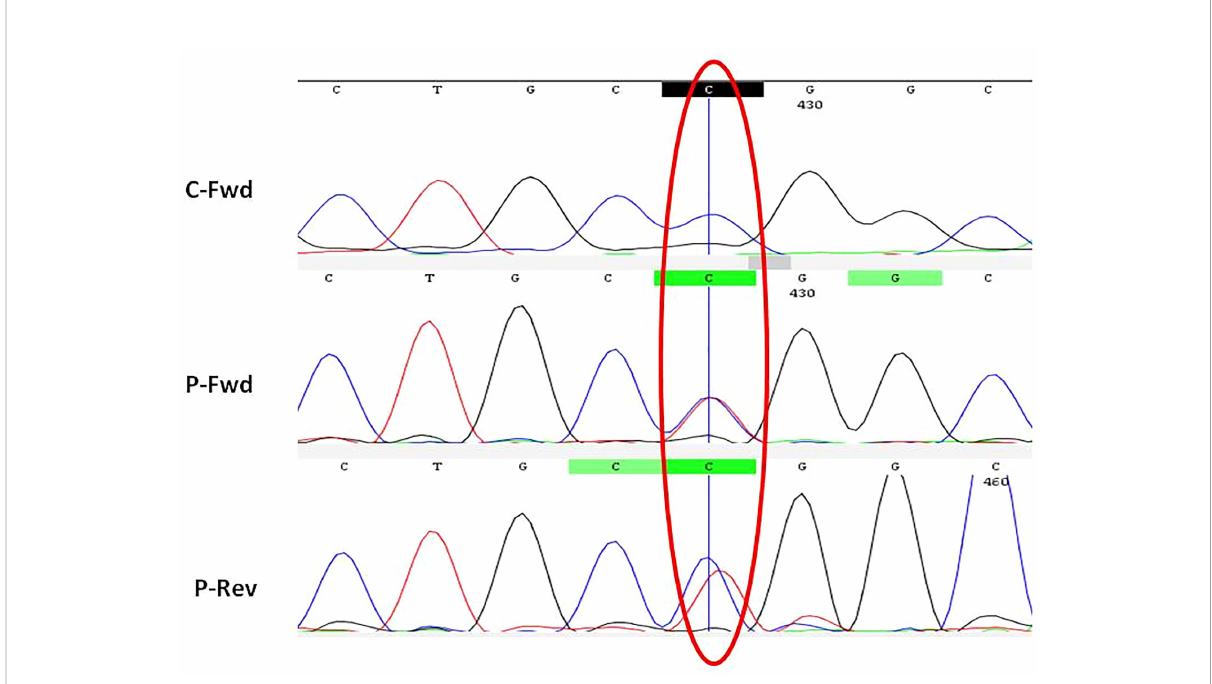
FIGURE 3 Electropherogram showing NOD2 gene (Exon-4) with missense heterozygous variant (p.R334W). C, control; P, patient; Fwd, forward; Rev,